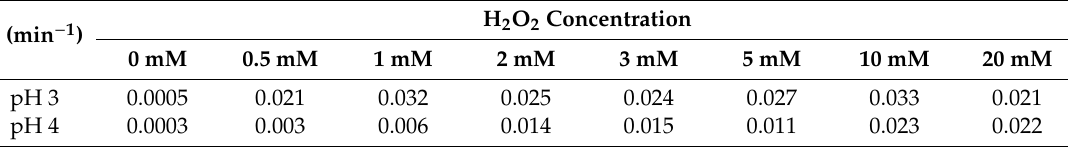
Table 5. Kinetic constant ( k ) for the degradation processes at di ff erent H 2 O 2 concentrations at pH 3 and 4 in the presence of Fe 3 O 4 / HA as a catalyst. The higher the value expressed by the kinetic constant, the higher the rate of degradation, which results in a better e ffi ciency of the system.